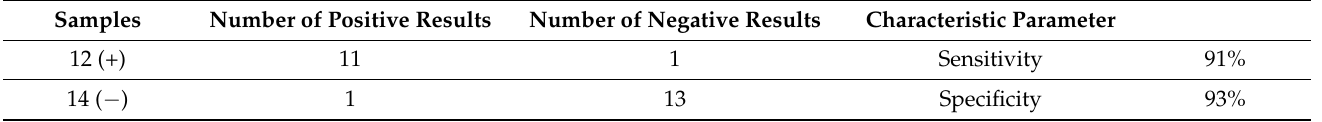
Figure 2. ( a ) Comparison of the results obtained with the developed smartphone-based LFIA kit (CEA found) and CEA reference (commercial ELISA kit) in the measurement of CEA in clinical samples. ( b ) The estimated CEA levels corresponding to each sample, resulting from the analysis facilitated by the smartphone-based platform. The clinical serum samples were classified in two groups: CEA-positive (+, n = 12 samples), and CEA-negative ( − , n = 14 samples). ( c ) ROC analysis, with area under the curve (AUC) of 0.99. Table 2. Characteristics of the developed smartphone-based LFIA kit in the analysis of clinical serum samples.